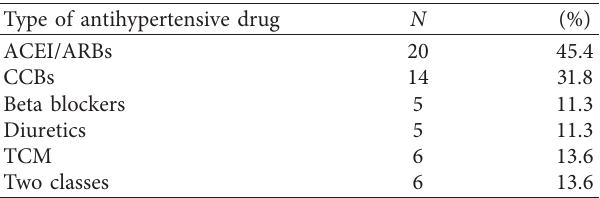
Table 6: Use of antihypertensive medications in the treated